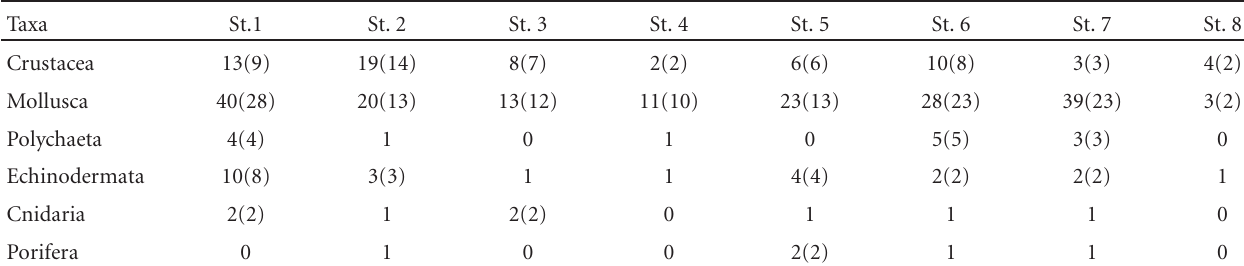
Table 4: Number of species and families (parenthesis) of taxonomic groups in the sampled localities of Bahia Malaga estuary.